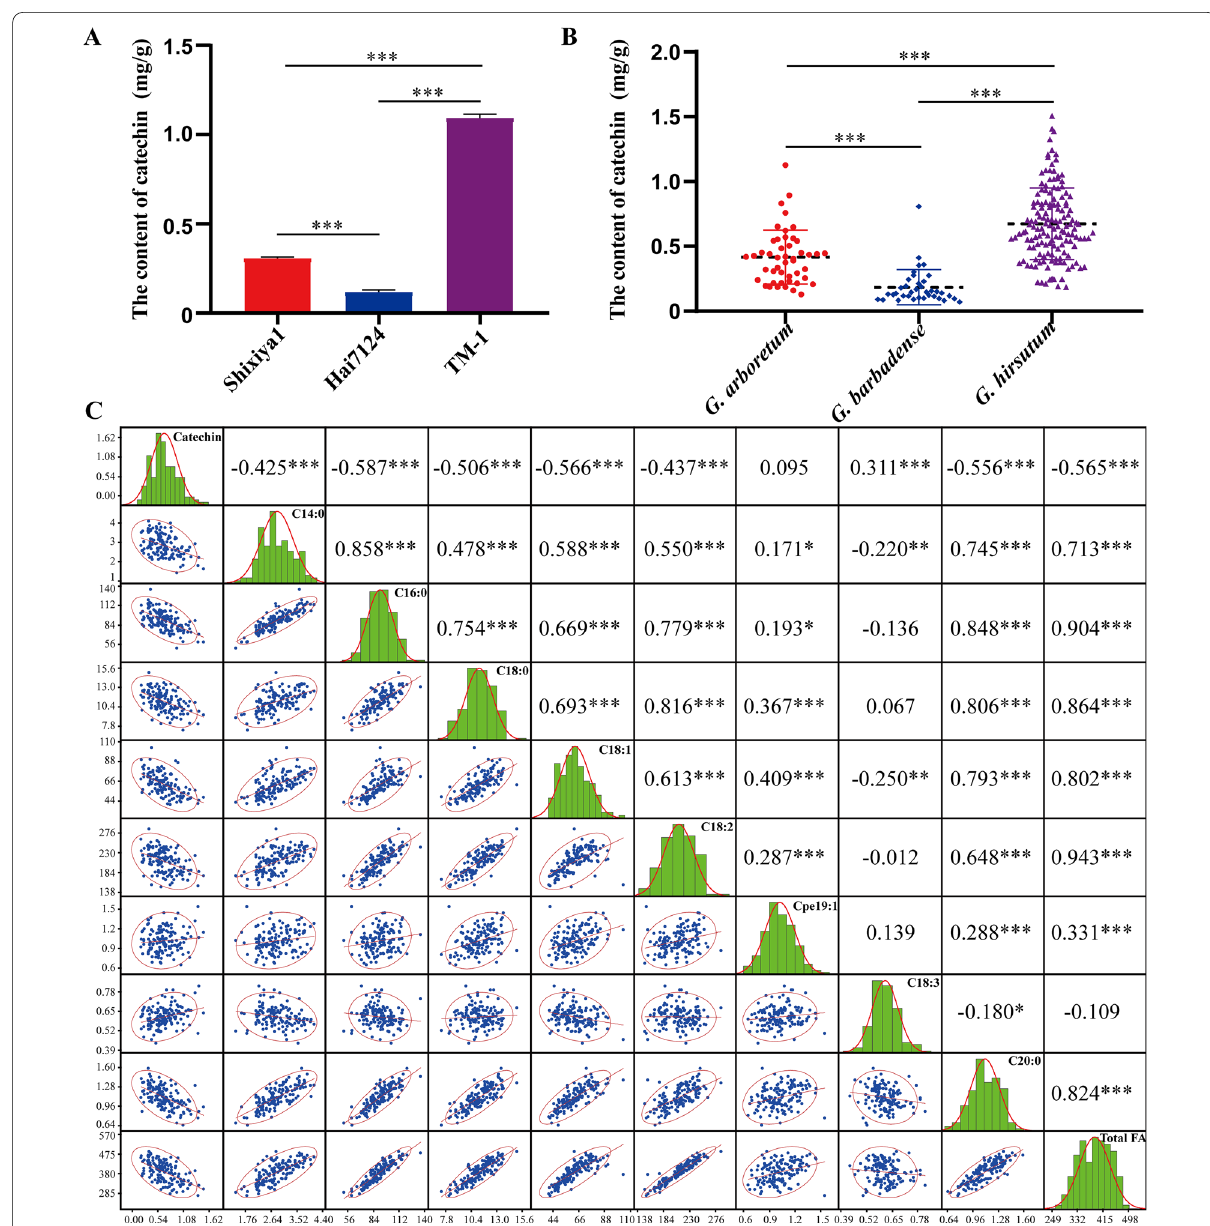
Fig. 2 Assessment of differential catechins content and correlation analysis in core collections of Gossypium . A The contents of catechin in Shixiya1, Hai7124 and TM-1 measured by HPLC. B Distribution of the catechin content in three cotton species ( G. arboreum , G. barbadense , and G. hirsutum ) C Frequency distribution of phenotypic variation of catechin and oil-related traits, and correlation analysis in core collections of G. hirsutum . Myristic acid (C14:0); Palmitic acid (C16:0); Stearic acid (C18:0); Oleic acid (C18:1); Linoleic acid (C18:2); Cyclopropene fatty acid (C19:1); Linolenic acid (C18:3); Arachidic acid (C20:0) and Total fatty acids (Total FAs). Columns show the mean SD with three replicates. *, **, *** represent P < 0.05, P < 0.01, and ± P < 0.001,